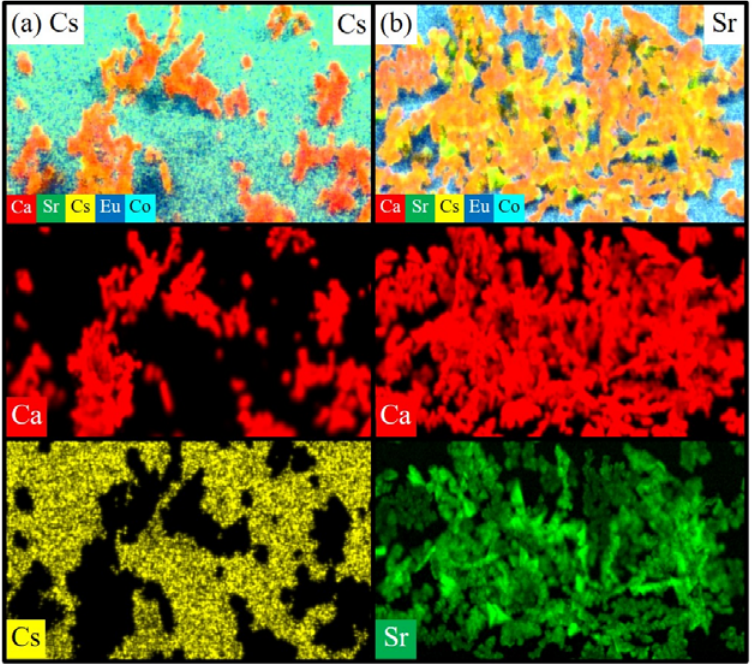
Figure 8. Example micro-XRF element maps of precipitates in leachates: Solidified cement specimens doped with ( a ) Cs and ( b ) Sr.